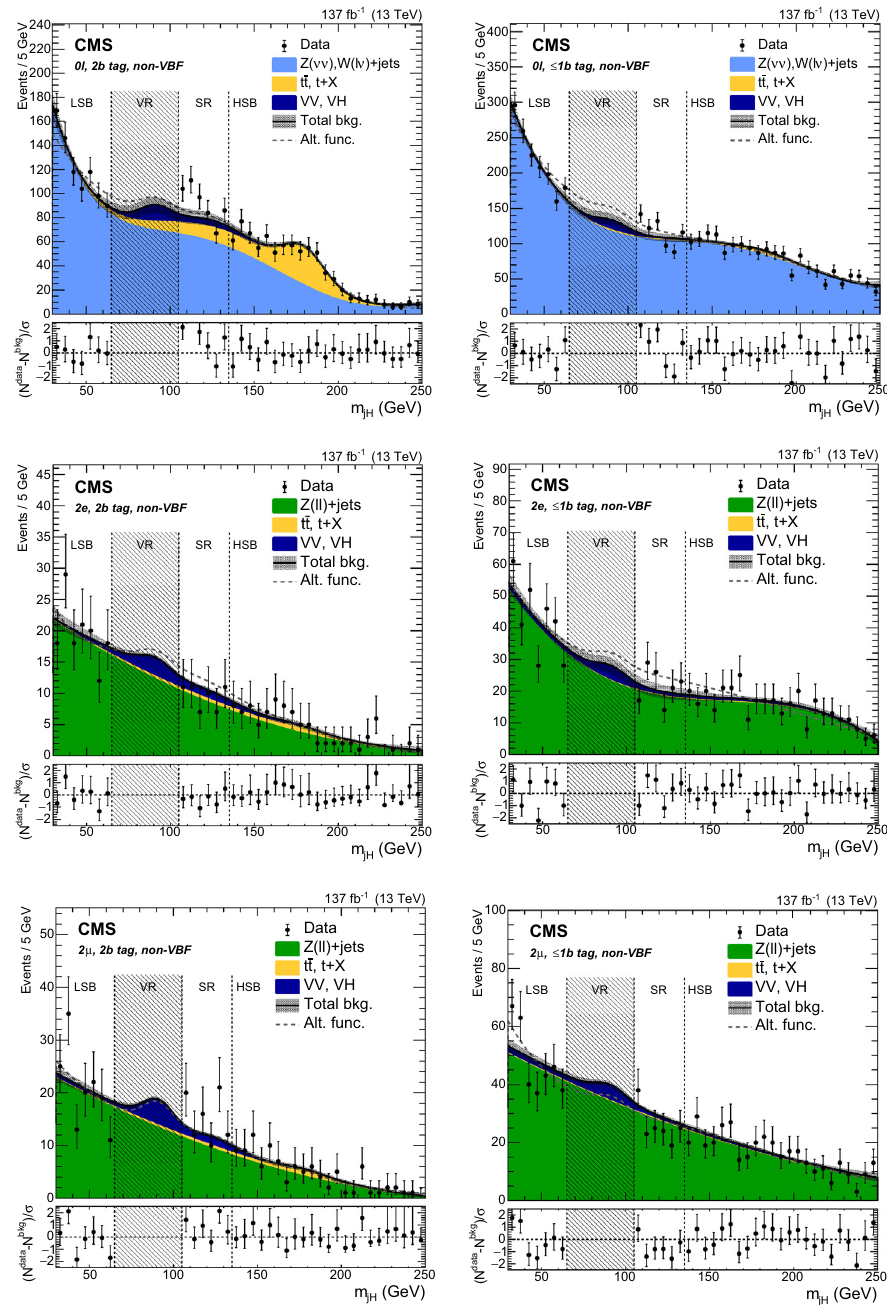
Fig. 3 Fit to the m j H distribution in data in the 2b tag (left column) and ≤ 1b tag (right column) non-VBF categories, for 0 (cid:4) (upper row), 2e (middle row), and 2 μ (lower row). The shaded bands around the total background estimate represent the uncertainty from the fit to data in the jet mass SBs. The observed data are indicated by black markers. The vertical shaded band indicates the VR region, which is blinded and not used in the fit to avoid potential contamination from VV resonant signals. The dashed vertical lines separate the LSB, VR, SR, and HSB. The bottom panel shows ( N data − N bkg )/σ for each bin, where σ is the statistical uncertainty in data. In the ≤ 1b tag, non-VBF categories, m X or m T X